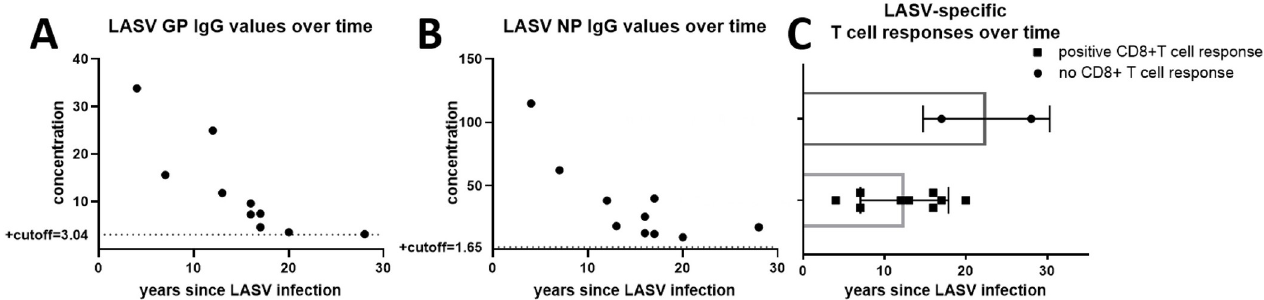
Fig 7. A and B ) LASV GP and NP IgG values decrease over time from infection (N = 10) C ) LASV specific T cell responses to 10-day proliferation assay decrease over time from infection (N = 11). https://doi.org/10.1371/journal.pntd.0010882.g007 who had positive CD8 T cell responses had an average percent neutralization of 51% (N = 7, ranging 15%-90%), and those without CD8 T cell responses had an average percent neutraliza- tion of 68% (N = 2, 59–75%) (Fig 8).